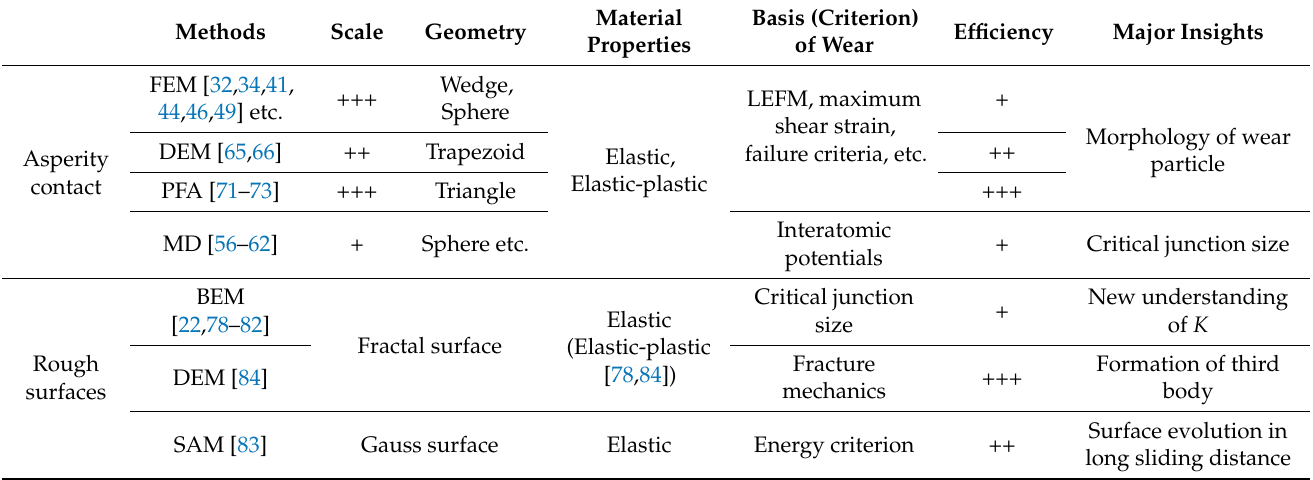
Table 1. Summary of wear modeling of asperity and rough